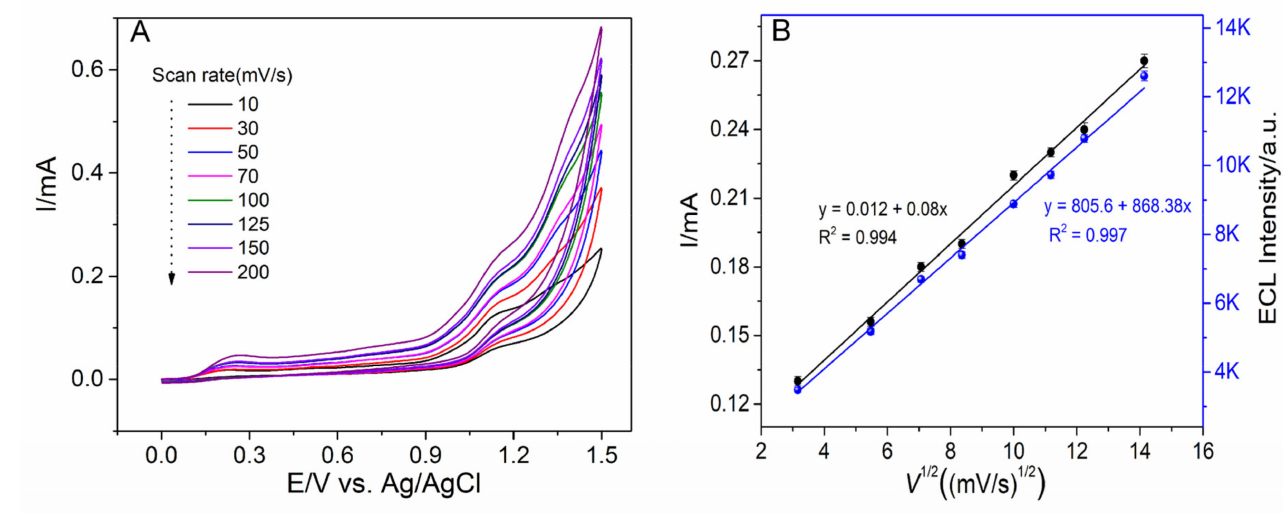
Figure 2. ( A ) Impact of scan rates vs. CVs and ( B ) Correlation of peak current and the ECL signal vs. square root of scan